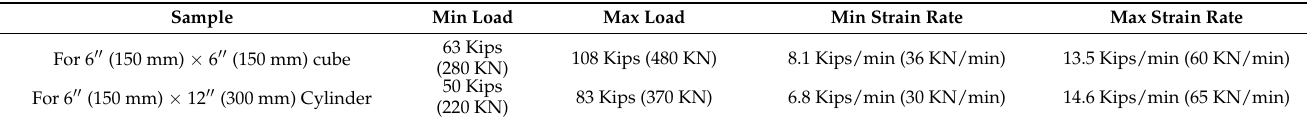
Table 5. Loading and Strain rates for Compression testing of the